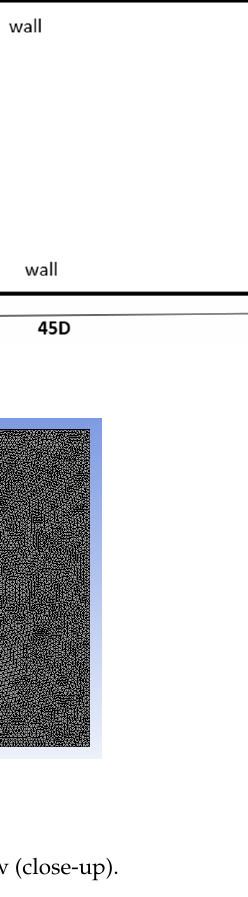
Figure 2. ( a ) Grid; ( b ) elements view (close-up).